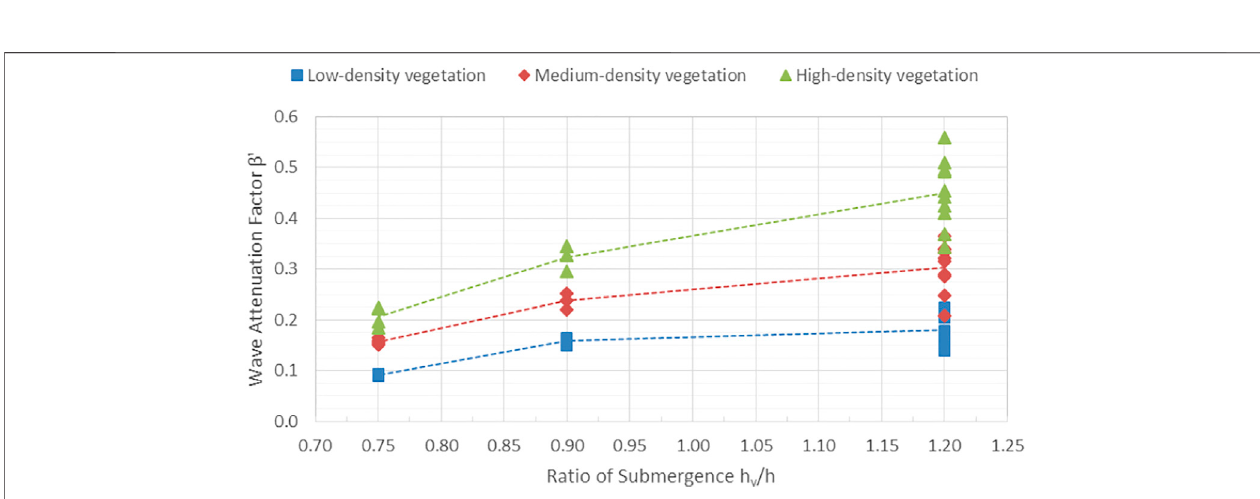
FIGURE 10 | Variation in wave attenuation factor with submergence ratio for arti fi cial marshes with different vegetation densities. Symbols denote results from individual tests spanning a range of wave conditions. Dashed lines connect average values for each submergence ratio.